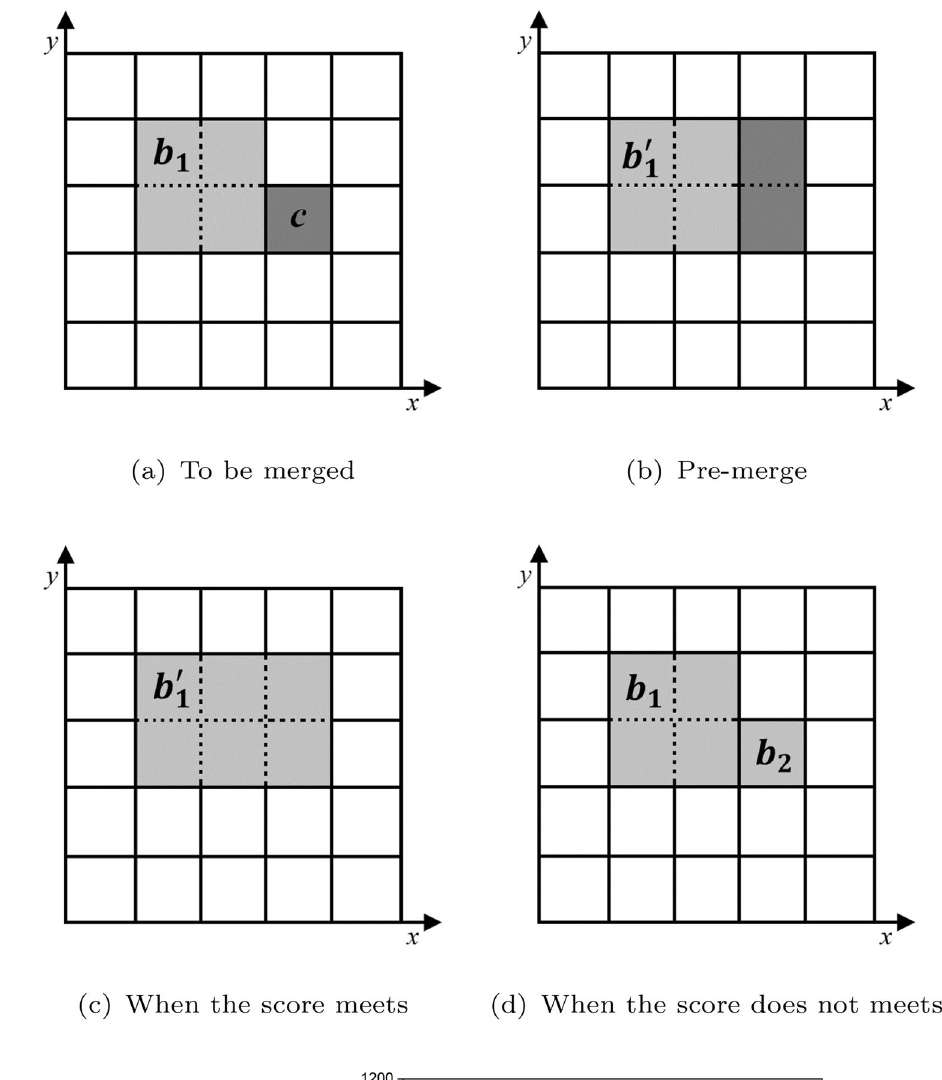
Fig. 12 The procedure of merg- ing cells